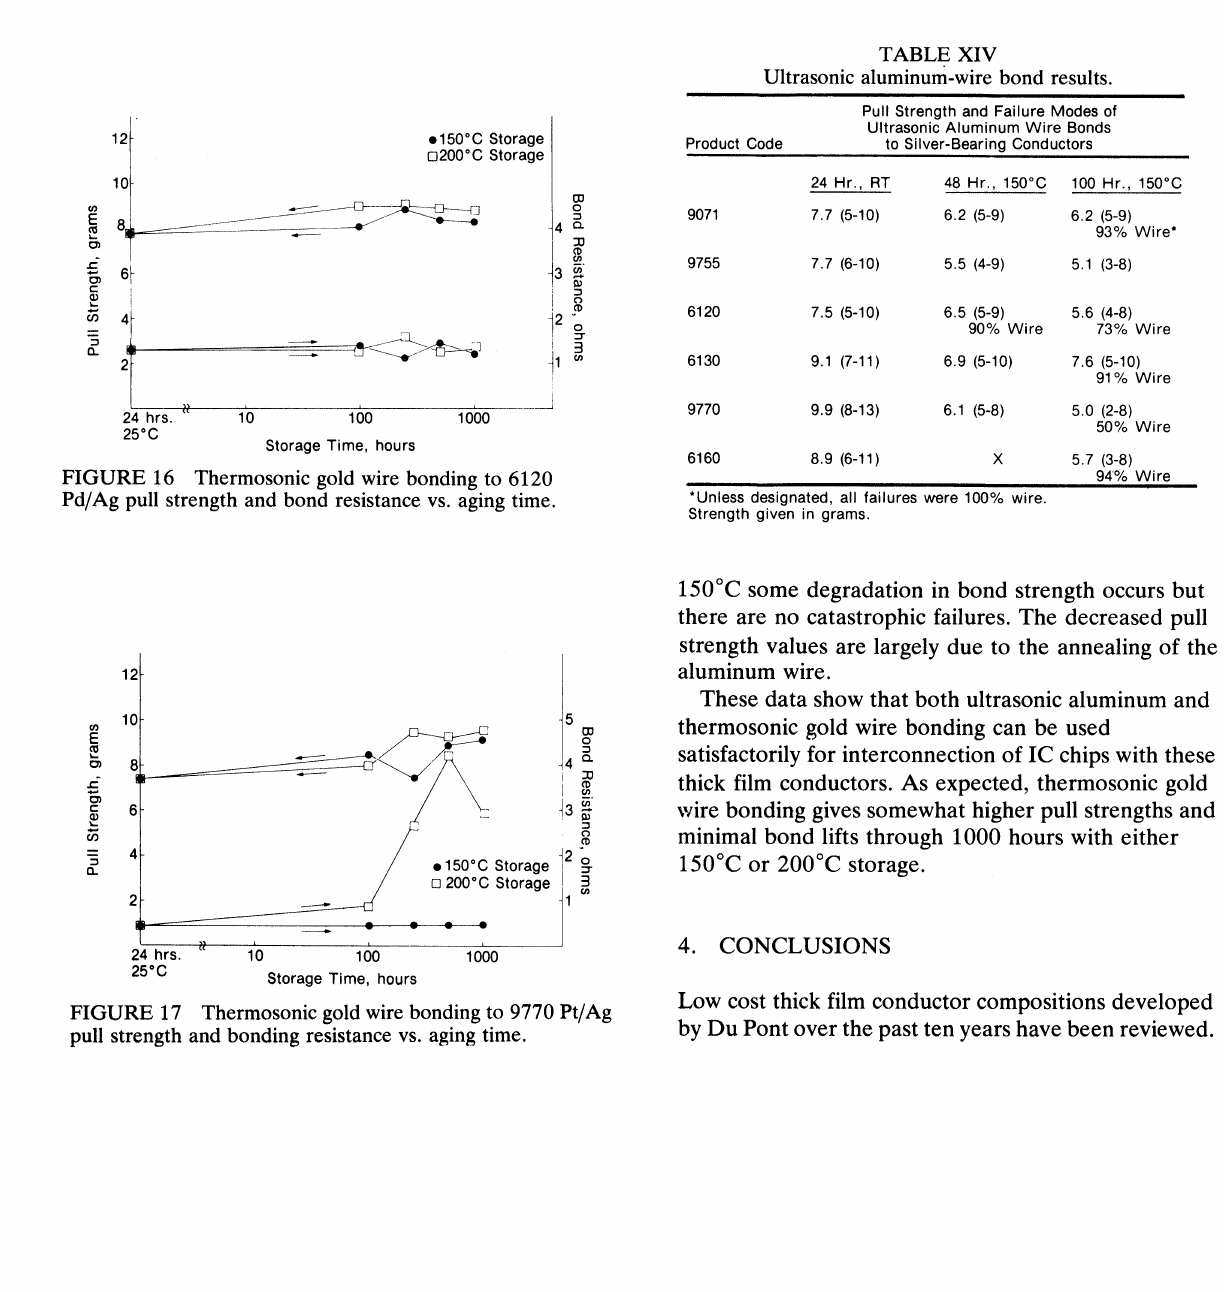
FIGURE 15 Thermosonic gold wire bonding to 4093 Pt/Pd/Ag pull strength and bond resistance vs. aging time.